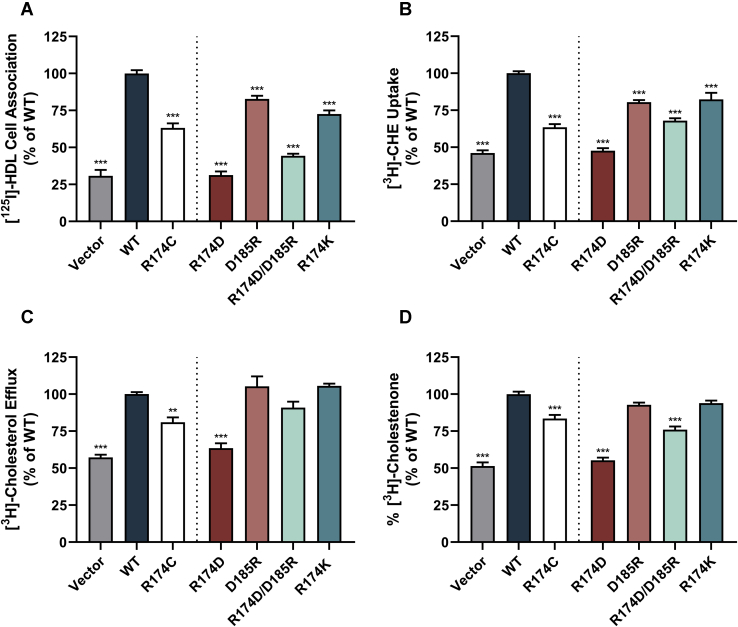
Cholesterol transport functions of salt bridge mutants vary by mutation. COS-7 cells transiently expressing WT or mutant SR-BI were assessed for (A) [125I]-HDL cell association, (B) [3H]CHE uptake, (C) [3H]cholesterol efflux, and (D) [3H]cholesterol accessibility. A dotted vertical line separates results for the human variant (previously shown in Fig. 3) from that of additional mutants generated to assess the importance of the putative salt bridge. The additional mutants are colored as follows: salt bridge-disrupting mutants (R174D-SR-BI and D185R-SR-BI) in dark red and light red, the charge swap mutant (R174D-SR-BI/D185R-SR-BI) in light teal, and the conservative mutant (R174K-SR-BI) in dark teal. All data are represented as the mean ± SEM of three independent transfections (n = 3) and are expressed as a percentage of WT-SR-BI activity. As determined by one-way ANOVA, ∗∗∗P < 0.001, ∗∗P < 0.01, and ∗P < 0.05 versus WT-SR-BI. CHE, [3H]cholesteryl hexadecyl ether; SR-BI, scavenger receptor class B type I.